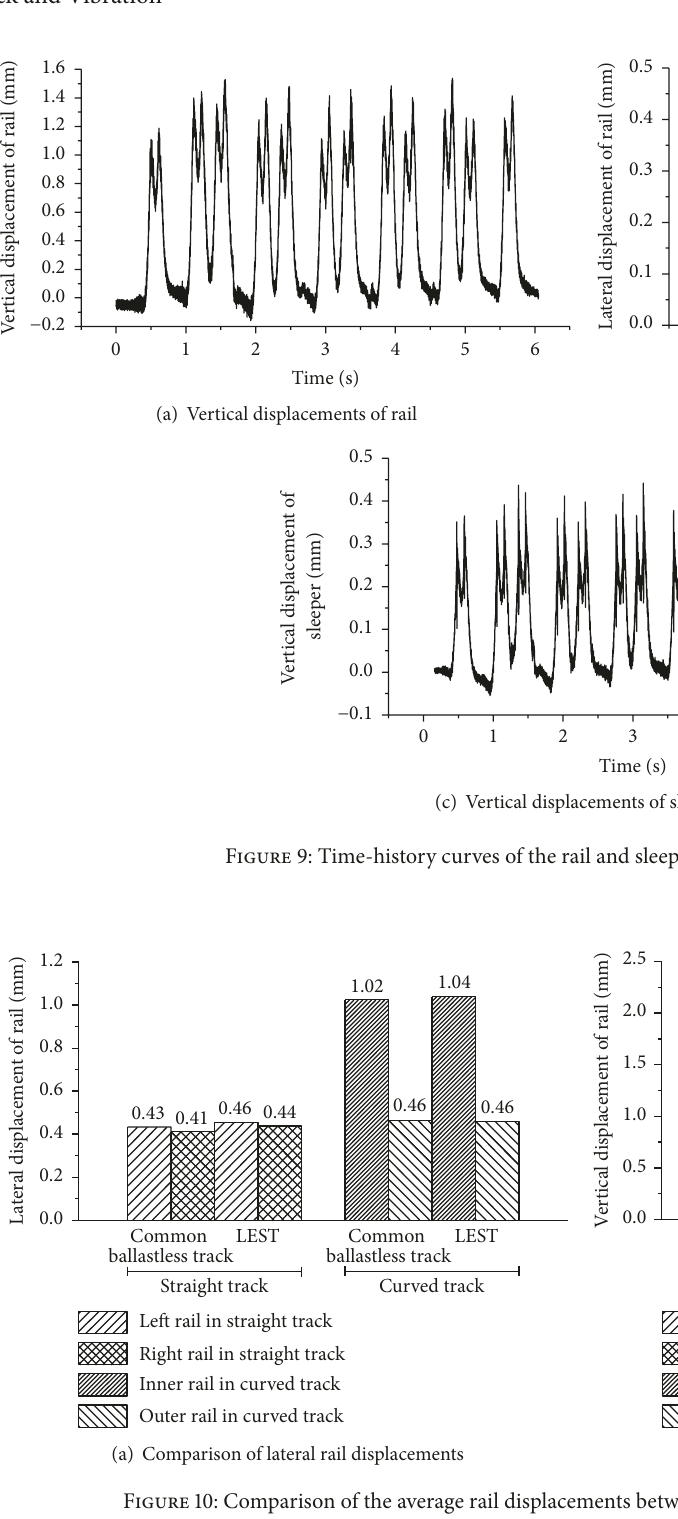
of the sleeper in straight track are 0.45 mm and 0.60 mm (inner rail) and 0.52 mm (outer rail) in curved